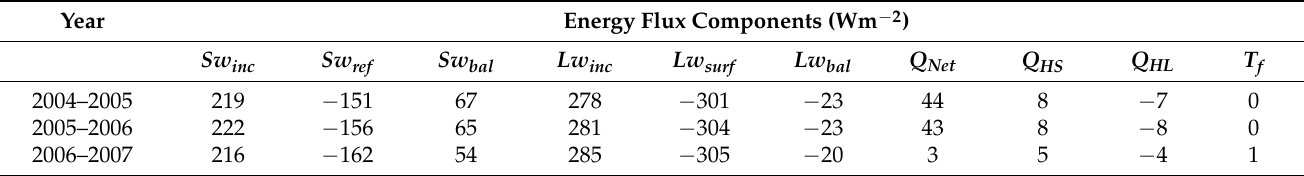
Table 6. Simulated annually averaged daily energy flux terms in the Artesonraju glacier.